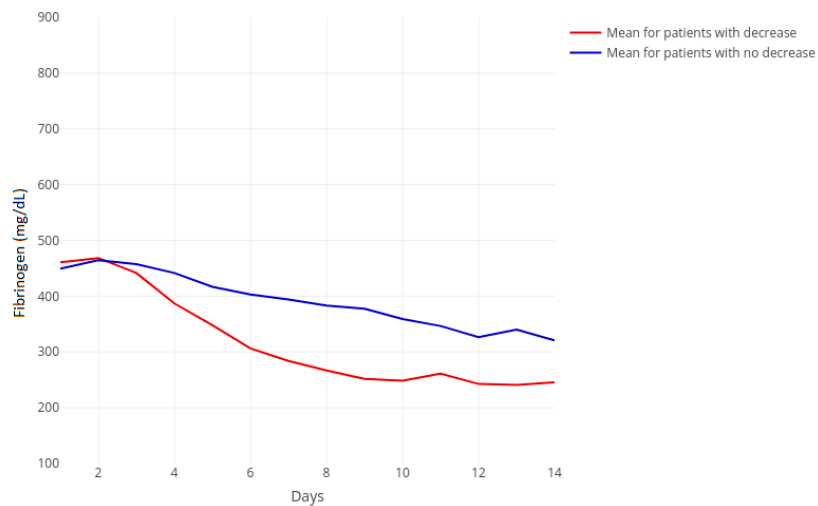
Figure 1. Time course of fibrinogen separated for decreasing (red, n = 59) and non-decreasing (blue, n = 71) groups with corresponding groupwise mean. The horizontal axis represents days of treatment beginning at zero as the timepoint seven days before treatment. Day n represents the n th day of treatment.